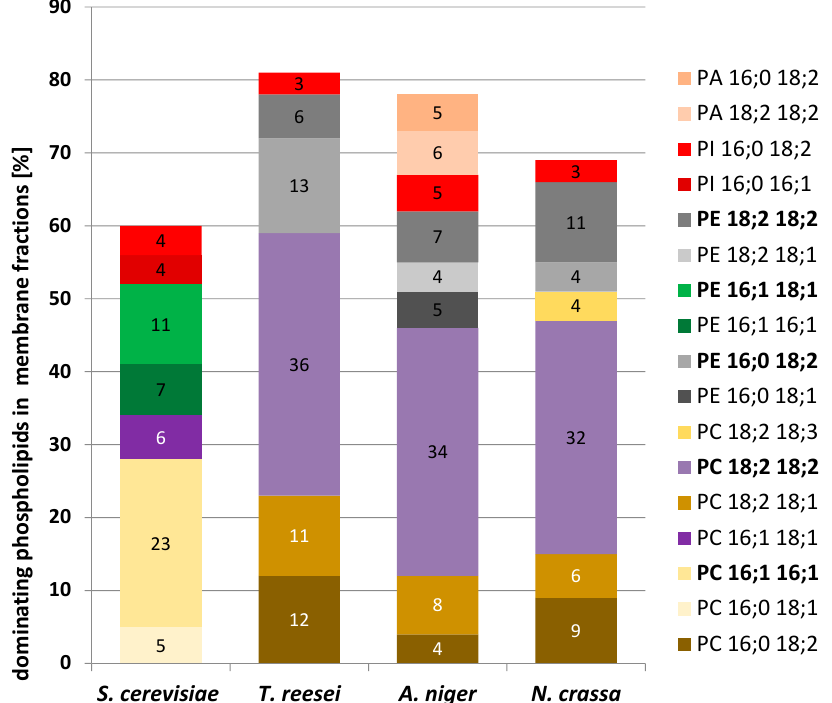
Figure 6. Most abundant phospholipid species in membrane fractions from yeast and filamentous Figure